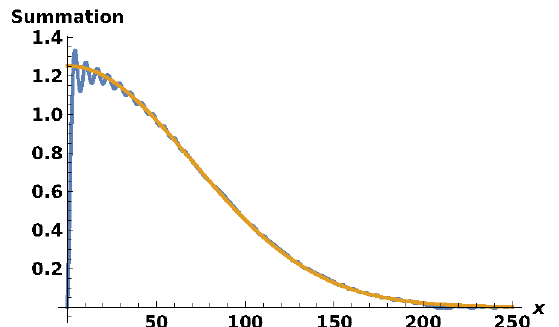
Figure 5. The use of a Gaussian function as f ( n ) in Equation (6) with a summation up to N = 200 integer orders results in a Gaussian function of x (abscissa). The blue curve is the sum of the Gaussian-weighted spherical Bessel functions, where the Gaussian function of n has a standard deviation of 70, and an amplitude of √𝜋 2⁄ . The yellow curve is the same Gaussian function of x . This illustrates how easily apodization functions can be included into the framework of the sum of spherical Bessel functions.